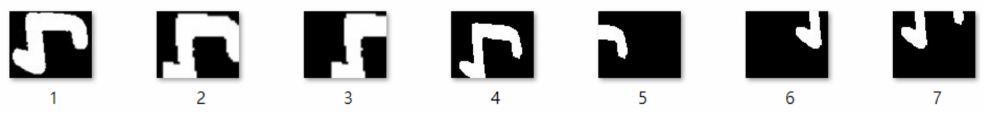
Figure 7. Symbol “ ㄅ ” in di ff erent types.